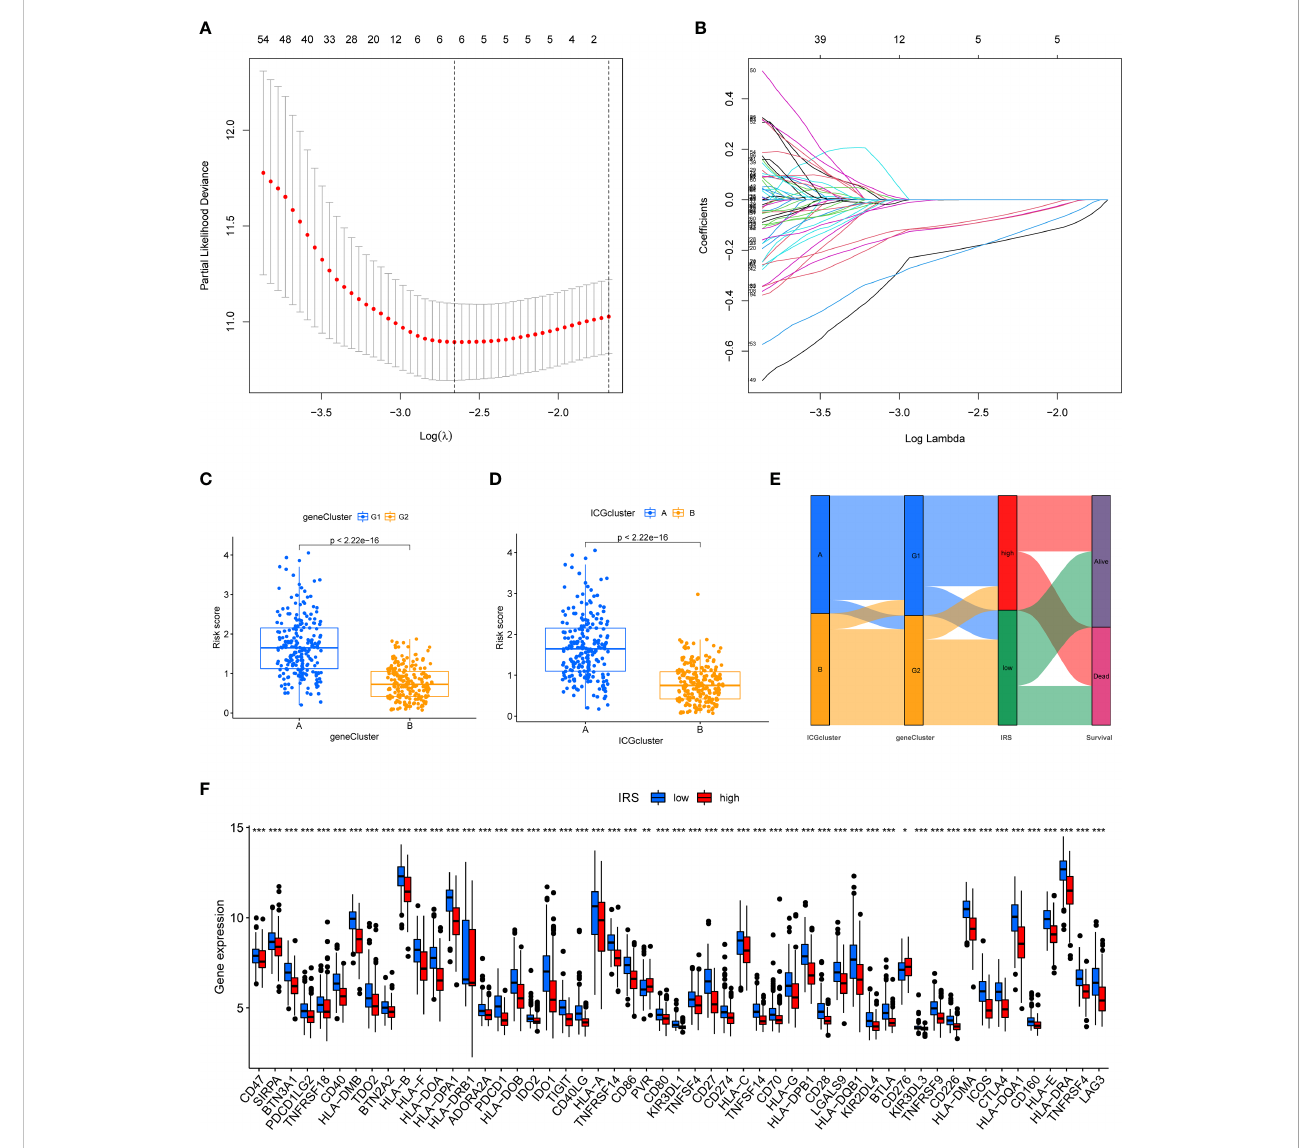
FIGURE 3 Construction of ICGs-related risk model. (A) Elucidation for LASSO coef fi cient pro fi les of prognostic ICGs. (B) The least absolute shrinkage was performed and construction of selection operator (LASSO) regression model. (C) The correlation between IRS model and ICGs geneClusters. (D) The correlation between IRS model and ICGs cluster. (E) Alluvial diagram of ICGs clusters in groups with different geneClusters, IRS, and survival status. (F) The expression of ICGs in high and low IRS group (*P < 0.05; **P < 0.01; ***P <